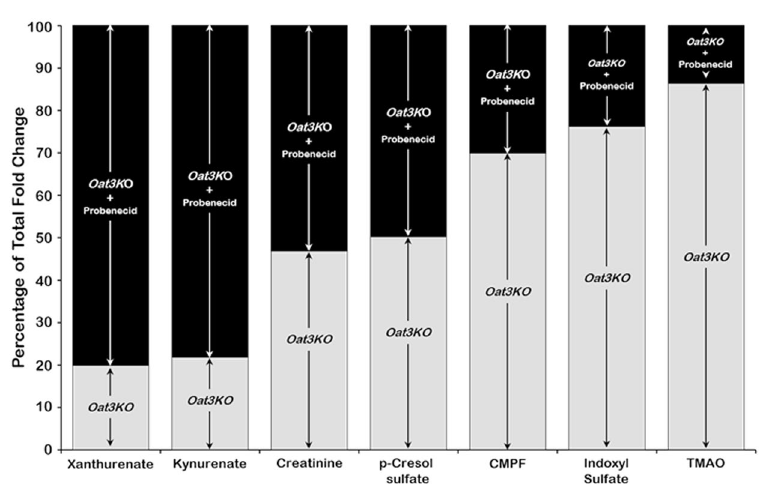
Figure 2. Stacked bar graph of the overall fold change in the plasma levels of the Oat3KO for some uremic toxins [i.e., Xanthurenate, Kynurenate, Creatinine, p-Cresol sulfate, 3-carboxy-4-methyl-5-propyl-2- furanpropionate (CMPF), Indoxyl sulfate and Trimethylamine N-oxide (TMAO)]. The data represents the percentage of the total fold change in the overall plasma concentration for each of these toxins/retention solutes in the Oat3KO (grey boxes) and in the Oat3KO treated with probenecid (black boxes). As described in the text, since in the Oat3KO , treatment with probenecid inhibits OAT1-mediated renal uptake, this allows one to see the contribution of each organic anion transporter to the handling of these metabolites (please also see Table